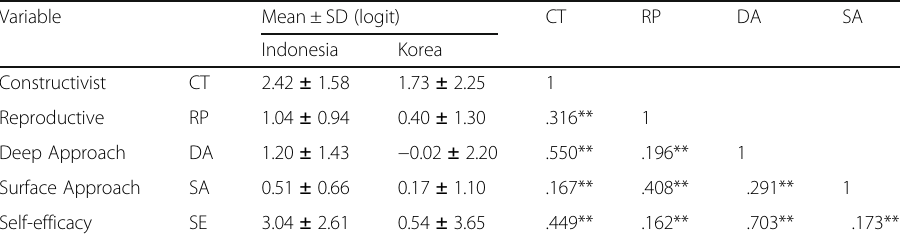
Table 2 Descriptive statistics and Pearson correlation test ’ s results for the used variables Variable Mean ± SD (logit) CT RP DA SA Indonesia Korea Constructivist CT 2.42 ± 1.58 1.73 ± 2.25 1 Reproductive RP 1.04 ± 0.94 0.40 ± 1.30 .316** 1 Deep Approach DA 1.20 ± 1.43 − 0.02 ± 2.20 .550** .196** 1 Surface Approach SA 0.51 ± 0.66 0.17 ± 1.10 Self-efficacy SE 3.04 ±